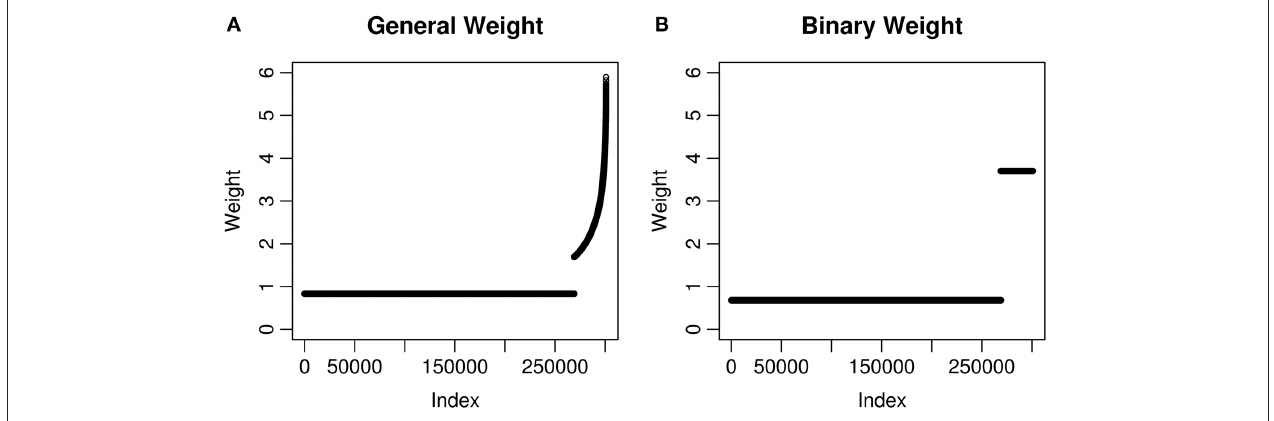
FIGURE 1 | Weights used in the MAGICS analysis. Each weight corresponds to a SNP and a hypothesis. The weights have been normalized to have mean 1 and shown in the ascending order. (A) The weights are based